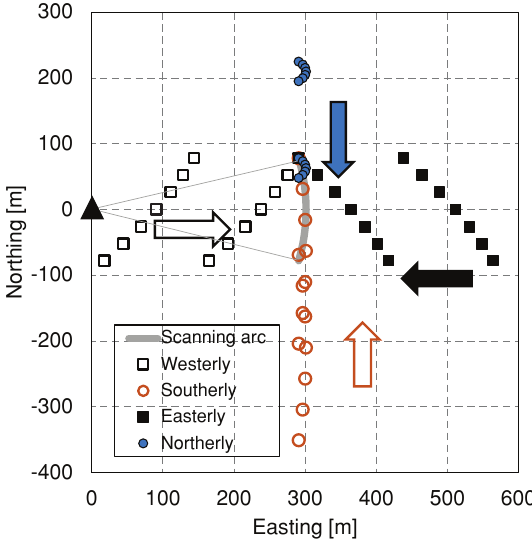
Figure 2. An example of the spatial distribution of air parcels sampled in two consecutive arc scans by a lidar at range distance s = 315m for four different wind directions (westerly, easterly, northerly, and easterly) under the following assumptions: (1) frozen turbulence, (2) the lidar is located at the origin (the dark triangle) scanning from θ = 75 to 105 ◦ with 5 ◦ increments with elevation angle φ = 17 ◦ , (3) the mean wind speed is 7ms − 1 and (4) the sam- pling interval is